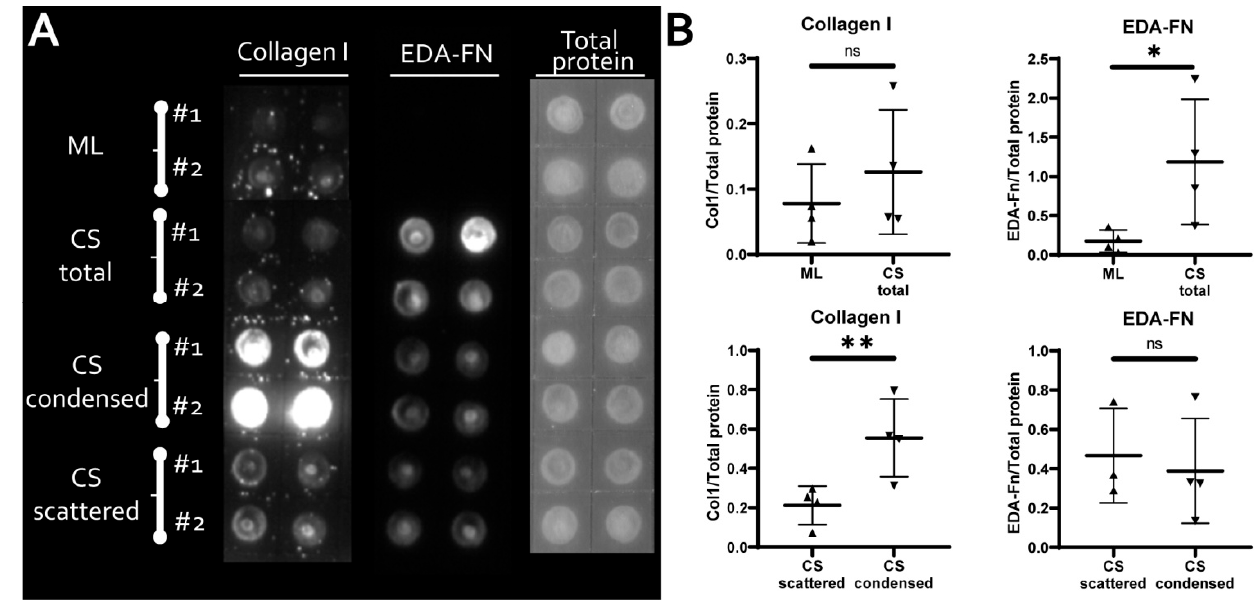
Figure 5. Characterization of the ECM composition in the MSC monolayer and cell sheets (CS) demonstrates the differential deposition of collagen-I and EDA-fibronectin. ( A ) Representative images of the collagen-I and EDA-fibronectin assays in lysates of a monolayer culture, total CS and microdissected condensed and scattered areas using dot-ELISA. One of the 4 biological replicates is presented. ( B ) Statistical analysis ( n = 4) of the ECM components (collagen-I and EDA-fibronectin) content normalized to the concentration of total protein measured by Amido black (panel A , right pair of lanes). In the figure graphs and histograms, significant differences were marked by * ( p < 0.05), ** ( p < 0.005), and not significant differences were marked by ns ( p > 0.05).